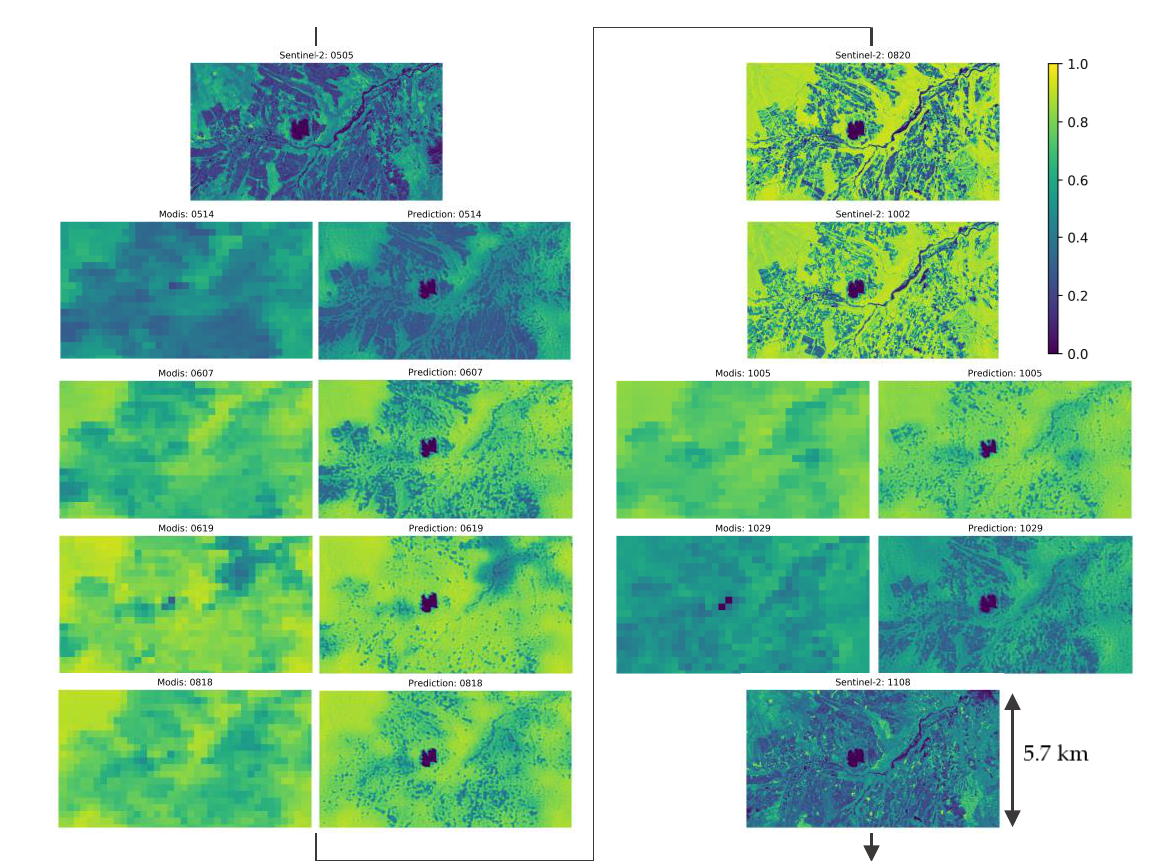
Figure 10. Sentinel-2 and predicted NDVI during the growing season (5 May 2020~8 November 2020). Type and date of images are shown in the title of each image. For each date of predicted NDVI, input 250-m NDVI are shown in the left column and predicted NDVI are shown in the right column.